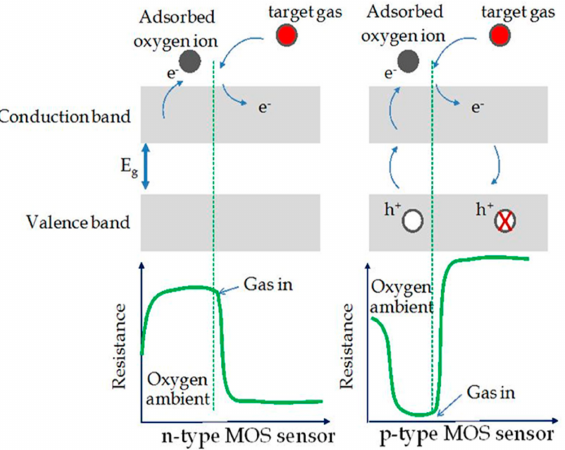
Figure 5. A schematic for the change of sensor resistance when exposed to the reducing gas in the cases of n–type and p–type metal oxide semiconductor sensors. Reprinted from Ref.